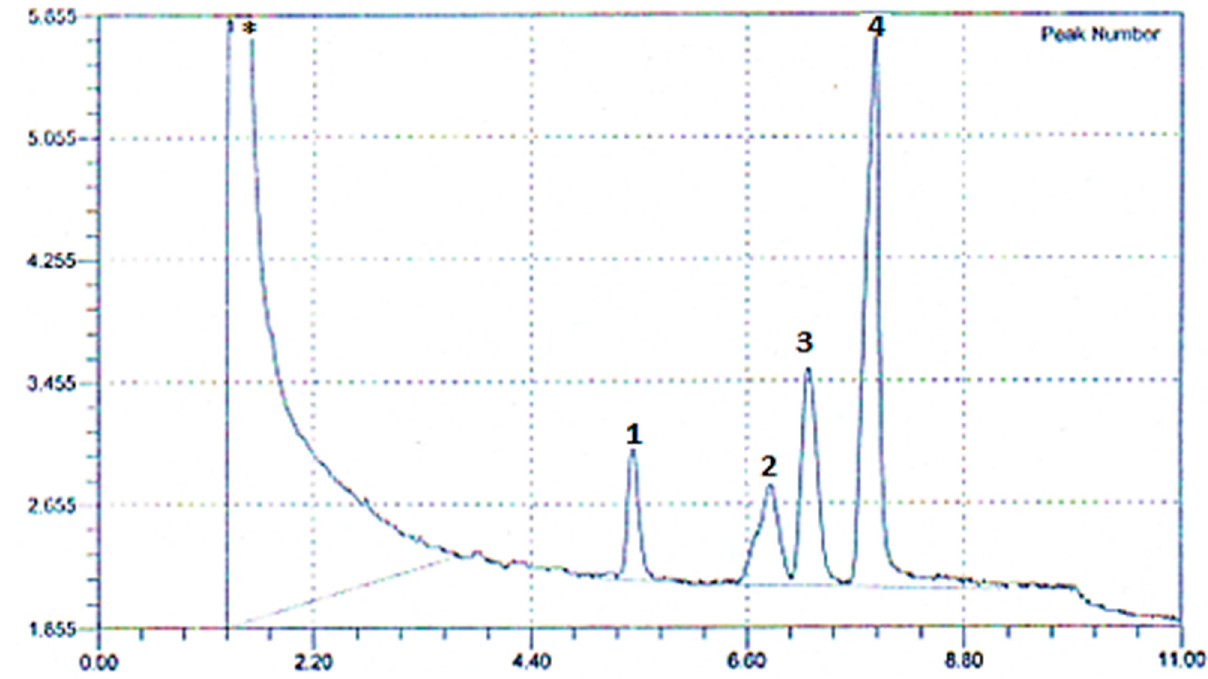
Figure 13. Amino acid at 2 mL/L GLC. (* is the solvent, 1 is the palmitic acid, 2 is oleic acid, 3 is a Linoleic acid and 4 is the α - α linolenic acid ) of chia ( Salvia hispanica L.) fixed oil content as impacted by various bio-stimulating materials.